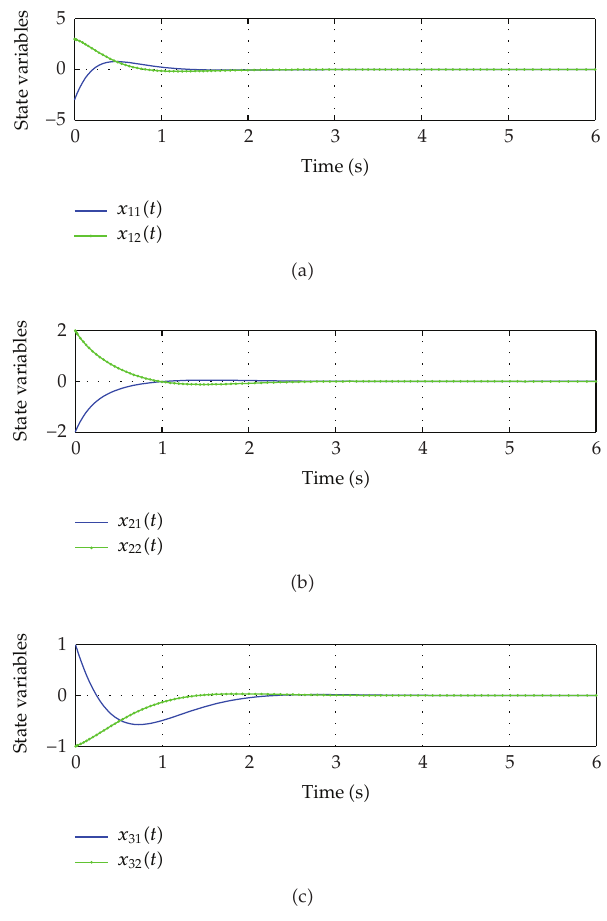
Figure 2: The state response with fuzzy control by Theorem